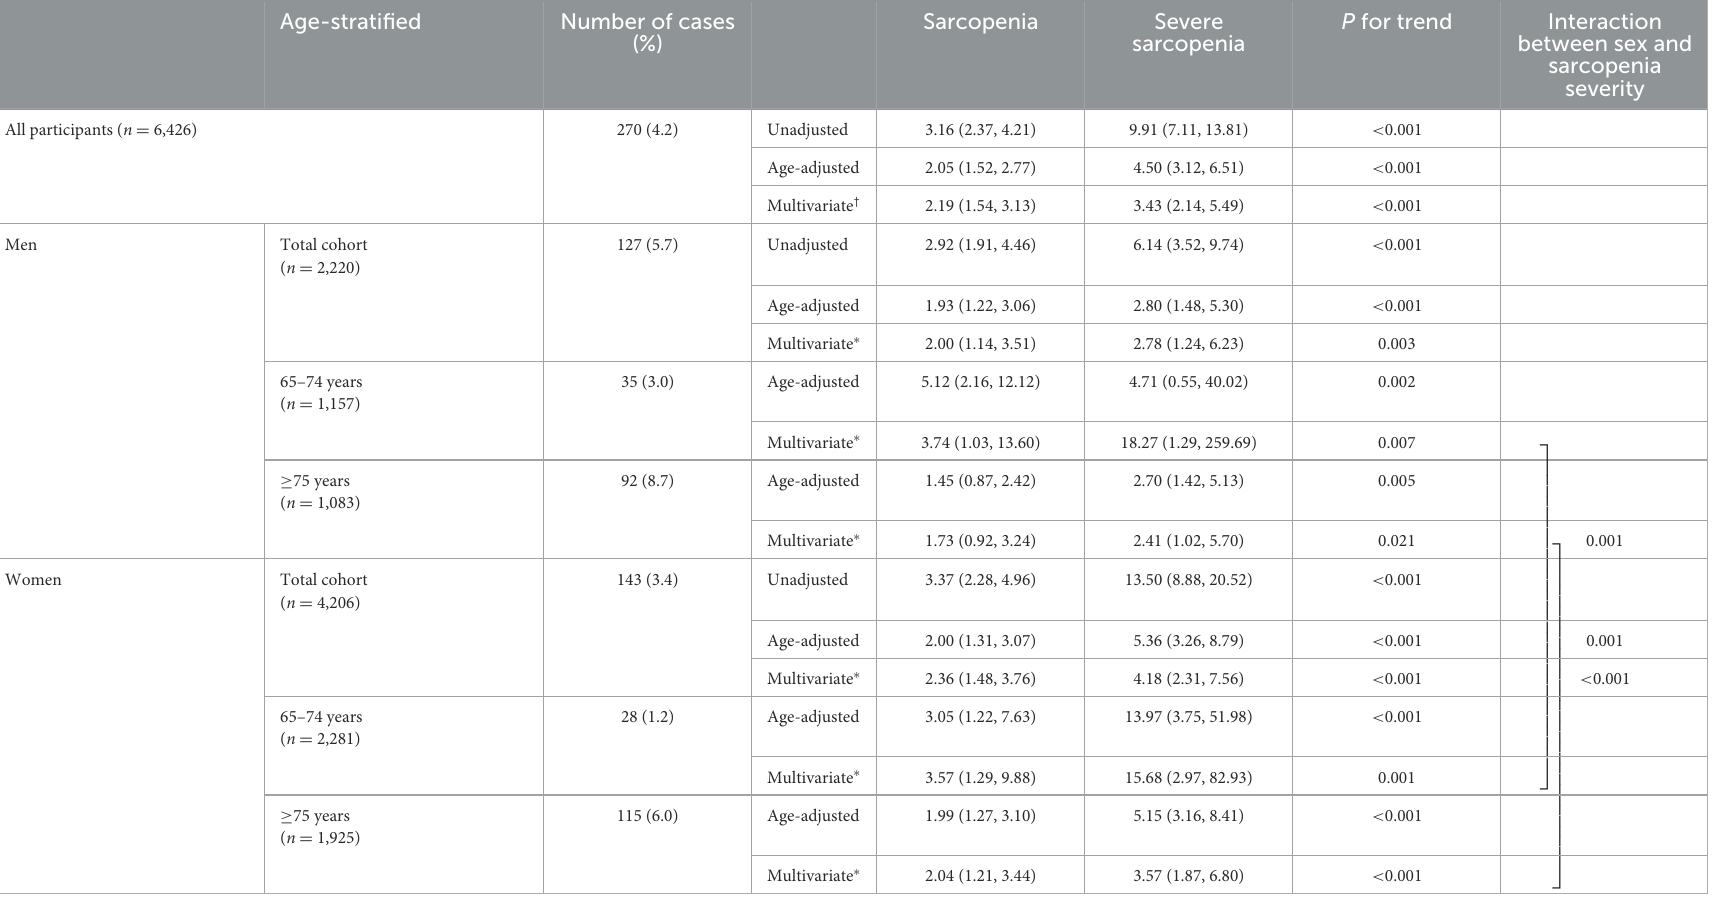
TABLE 2 Sex-stratified odds ratios (95% confidence intervals) of poor cognitive function according to sarcopenia status and gender. Age-stratified Number of cases